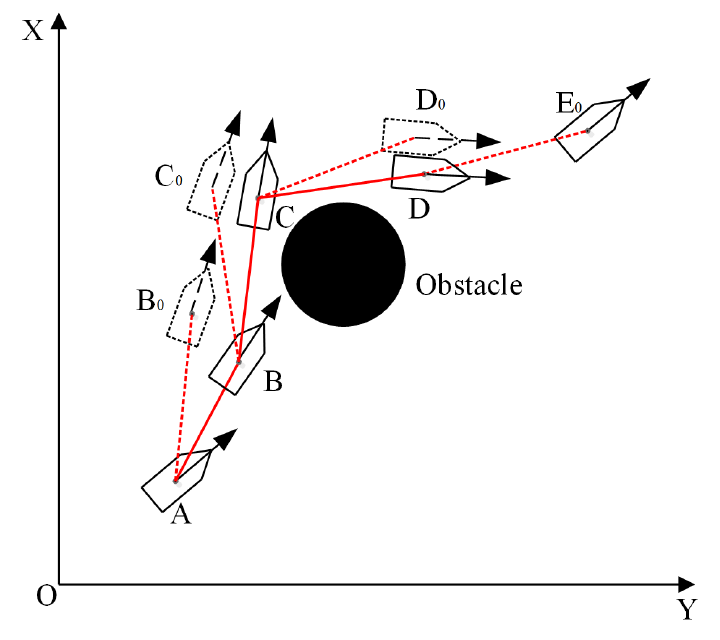
Figure 7. The actual and desired trajectories for collision